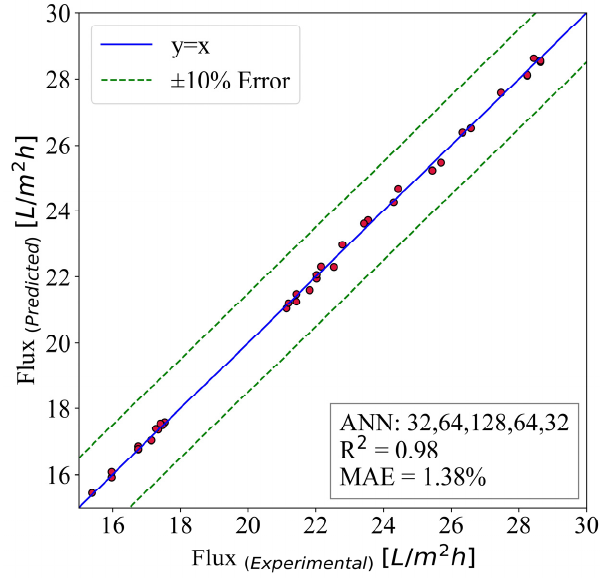
Figure 10. The ANN predictive model for flux.